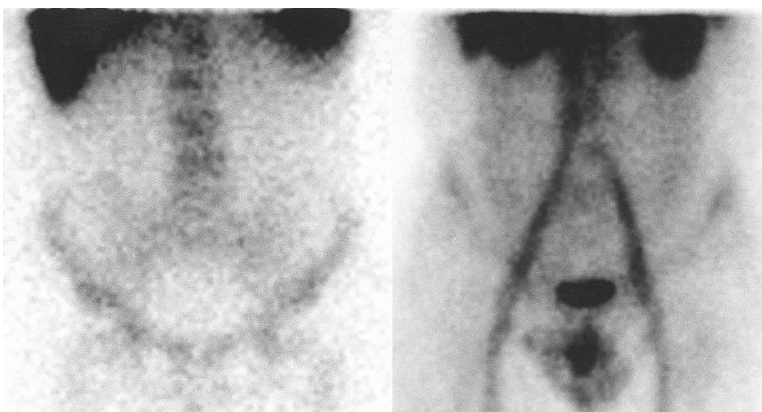
Figure 4. Comparison of 111 In-oxine labeled leukocyte scan (left) and 99mTc-labeled human immunoglobulin G scan (right) in the same patient (anterior view). The labeled immunoglobulin scan shows pathological uptake of the radiopharmaceutical on the ascending and descending colon, while leukocyte scan does not show areas of pathological leukocyte concentration.